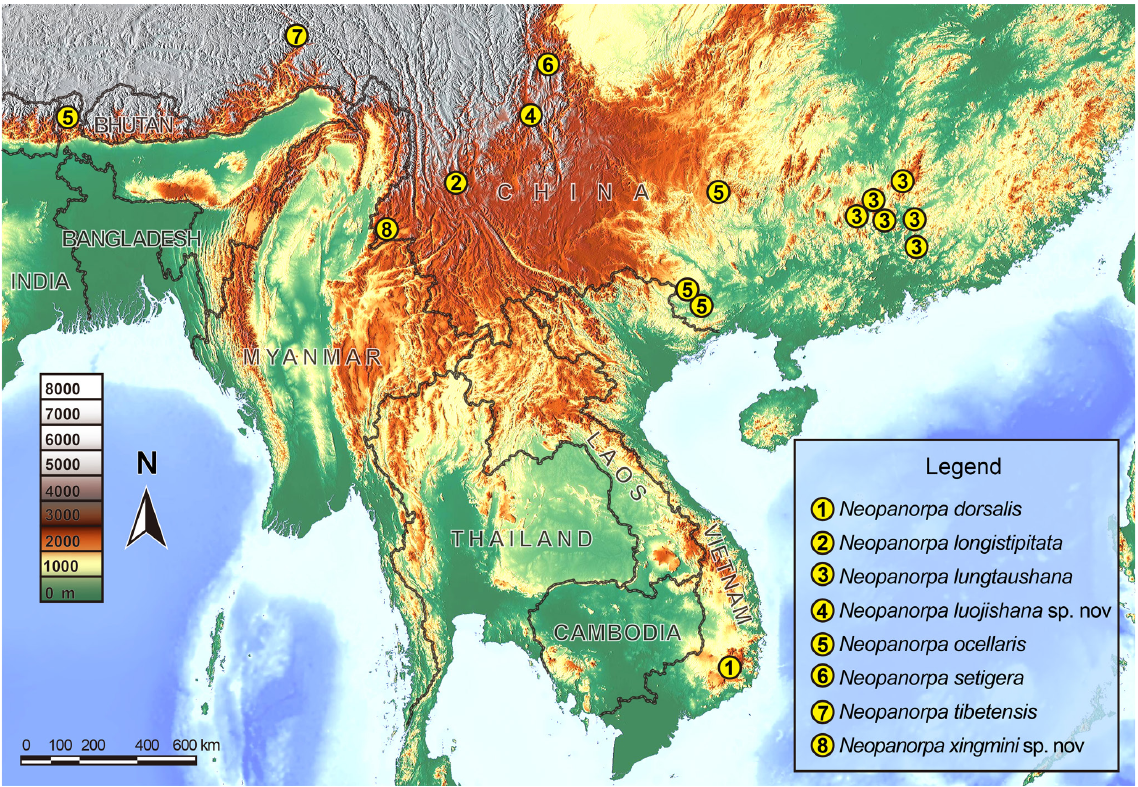
Fig. 7. Distribution map of Neopanorpa species discussed in this